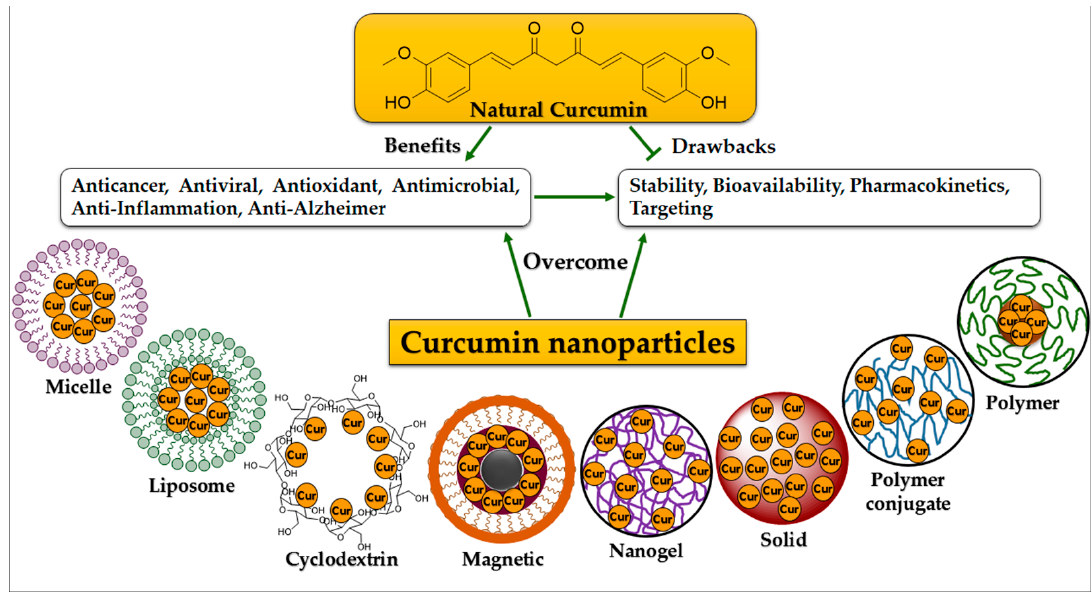
Figure 3. Nano-based formulations of curcumin. Many curcumin-based nanoformulations have a significant impact on pharmaceutical applications, which are effective in the treatment of a wide range of human disorders due to their anti-cancer, antioxidant, antimicrobial, and antiinflammation, and even anti-Alzheimer properties. Most nanoformulations are capable of overcoming curcumin’s weak hydrophobicity, as well as its poor stability and poor cellular bioavailability. Such nanoformulations are utilized for long-term preservation and circulation throughout the body.